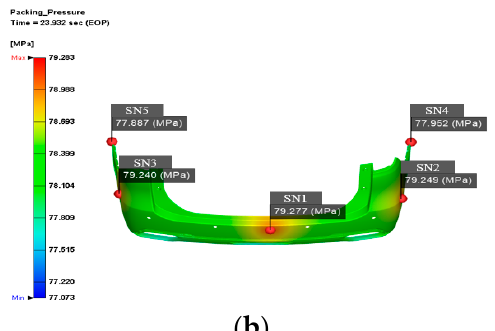
Figure 9. Classification of warpage of key length.